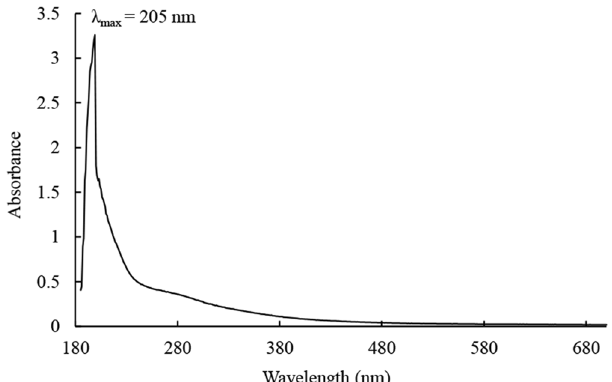
Figure 1. UV–Vis spectrum of StrSM.